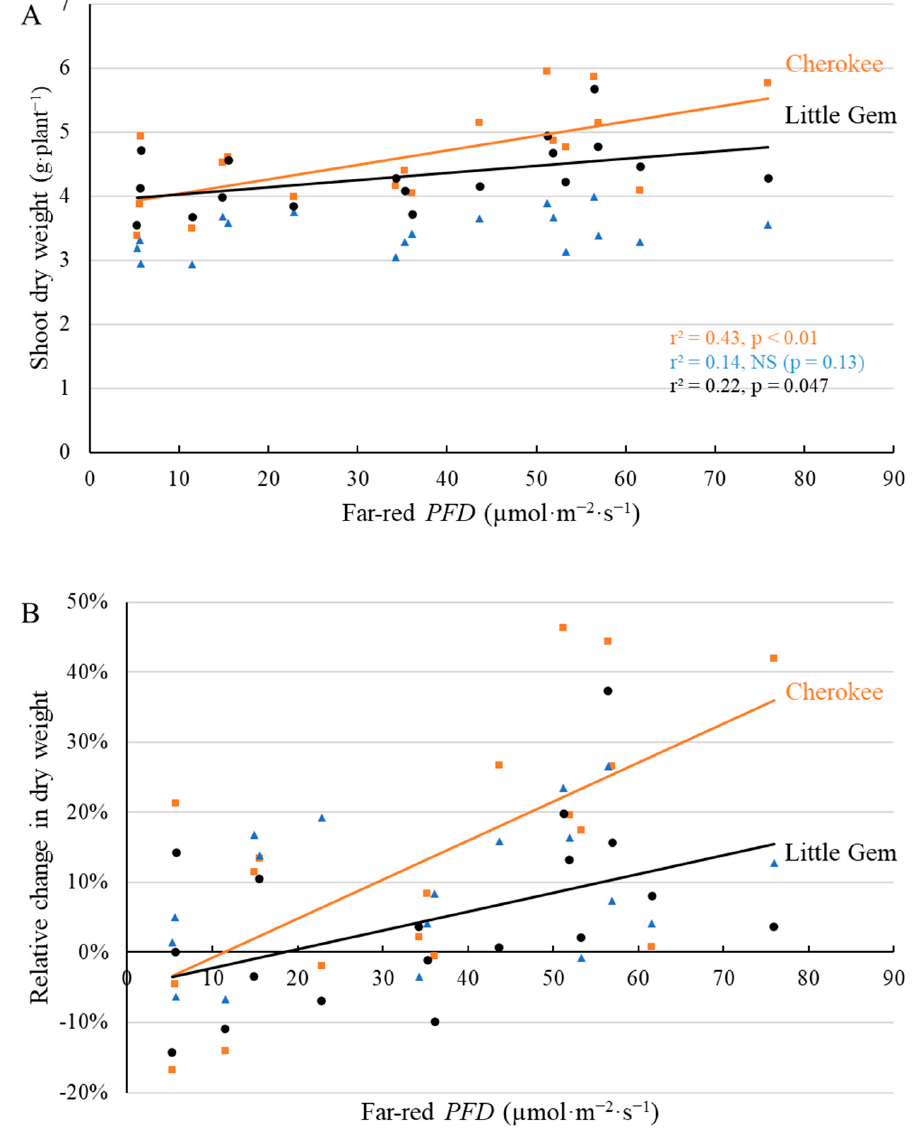
Figure 12. With a background of 204 µ mol · m − 2 · s − 1 white LED light, supplemental far-red photons linearly increased shoot dry weight ( A ) and relative shoot dry weight (( B ), compared to plants under no supplemental far-red light) at 35 days after the start of far-red light treatment for ‘Cherokee’ and ‘Little Gem’, but not for ‘Green Saladbowl’ (blue triangles) lettuce at 29 DAT. The r 2 and p values for regression of each cultivar apply to both graphs and are shown with the respective color.